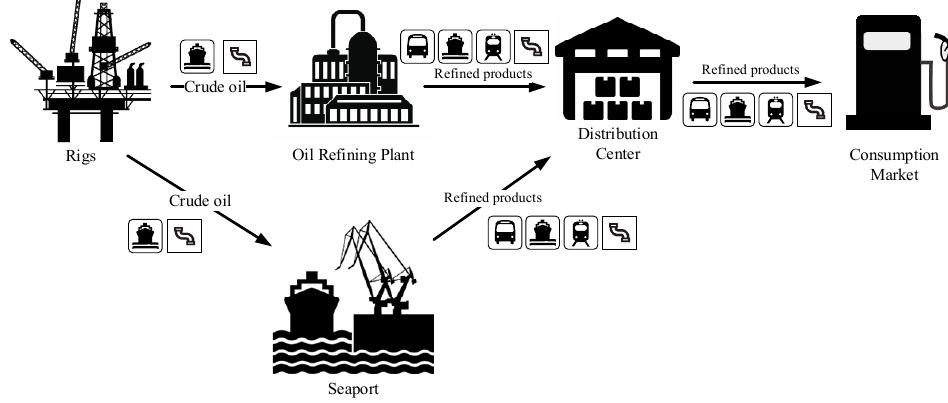
Figure 1. Petroleum supply chain network.